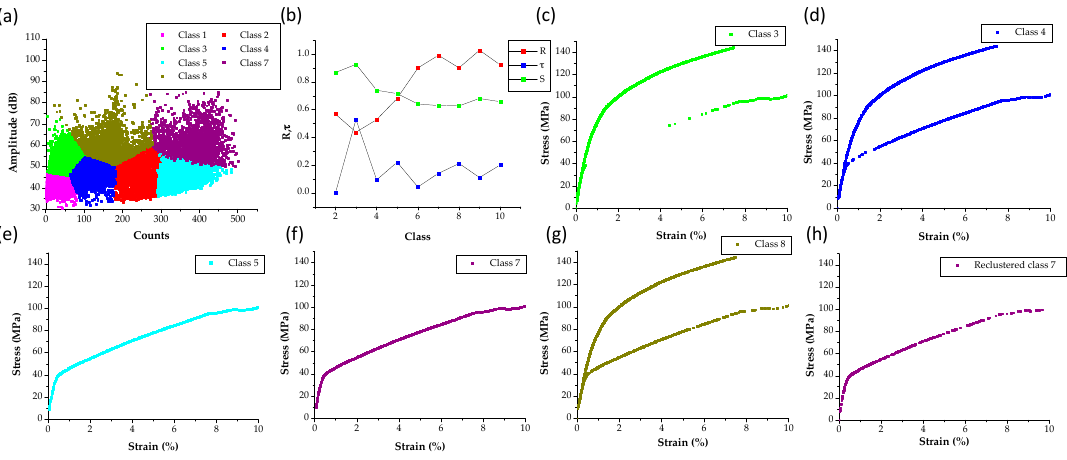
Figure 10. ( a ) K-Mean clustering results based on the combined AE datasets of both ND and RD tests that have a Peak Frequency between 350 and 550 kHz; ( b ) computed R , τ and S values against number of classes; ( c – g ) class 3–5 and 7–8 AE hits plotted as a projection on the ND and RD stress strain curves; ( h ) reclustered class 7 AE hits